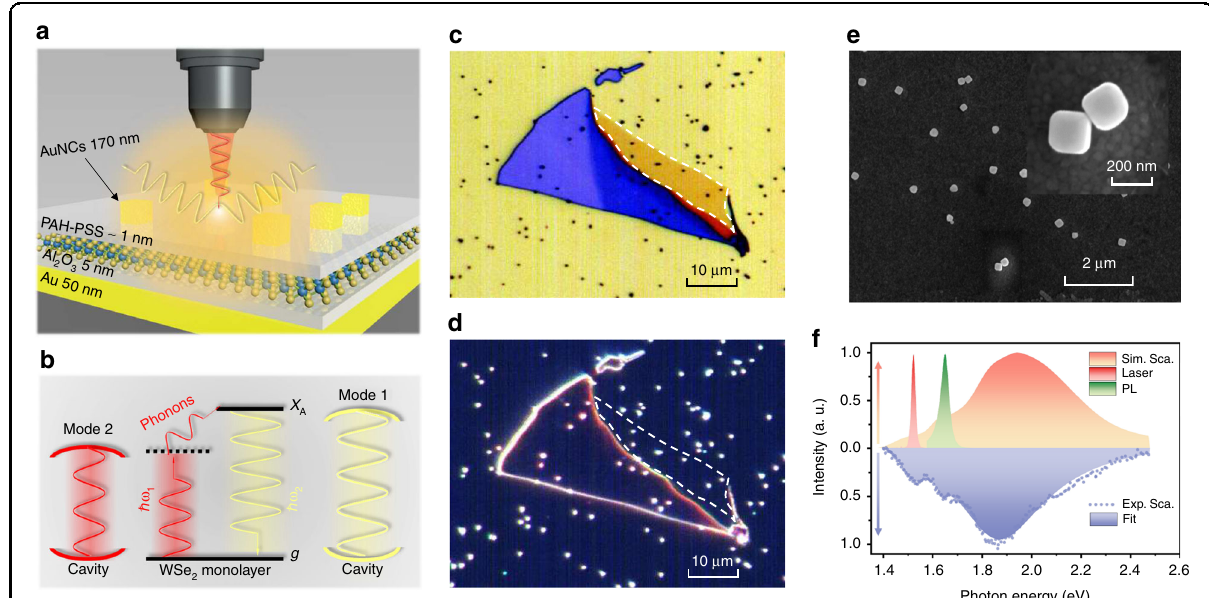
Fig. 1 Design and characterization of plasmonic upconverter devices. a Schematic of the designed Au nanocube/WSe 2 /substrate plasmonic upconverter devices. b Desired band alignment diagram of monolayer WSe 2 in plasmonic nanocavities and the photon upconversion process of 2D excitons. c Bright- and d dark- fi eld microscope optical images of a representative sample. e Scanning electron micrograph of 170 nm Au nanocubes on the substrate, and the inset shows a magni fi ed image from the top view. f Excitation laser and monolayer WSe 2 PL spectra overlapping the simulated scattering spectrum of a plasmonic nanocavity, which is consistent with experimental results. The excitation laser and upconverted emission spectra are doubly resonant with plasmonic cavity modes at 1.52 and 1.67 eV, respectively. All the spectra are